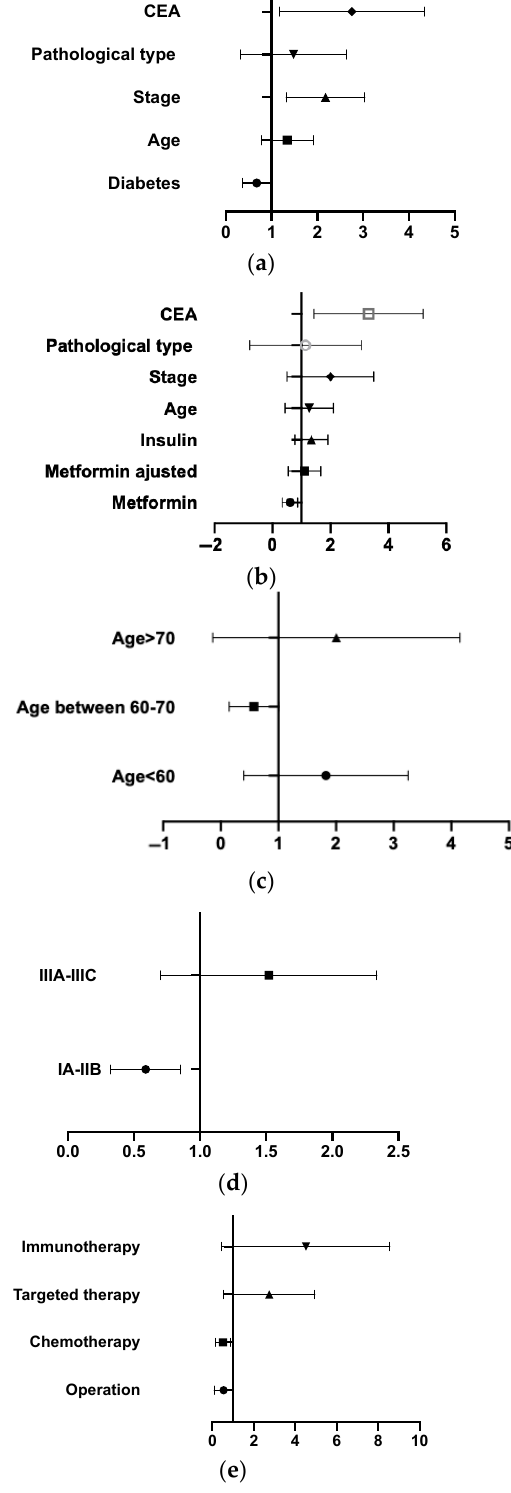
Figure 3. Associations of OS with status of T2DM in different groups. All the five figures were hazard ratio (95% confidence interval). ( a ) showed the impacts affecting OS in all patients, including age, stage, pathological type, CEA etc. ( b ) showed the impacts affecting OS in diabetes patients, including diabetic therapy, age, stage, pathological type, CEA etc. ( c ) showed the associations of OS with status of T2DM in age group. ( d ) showed the associations of OS with status of T2DM in different stage. ( e ) showed the associations of OS with status of T2DM in different cancer treatment.